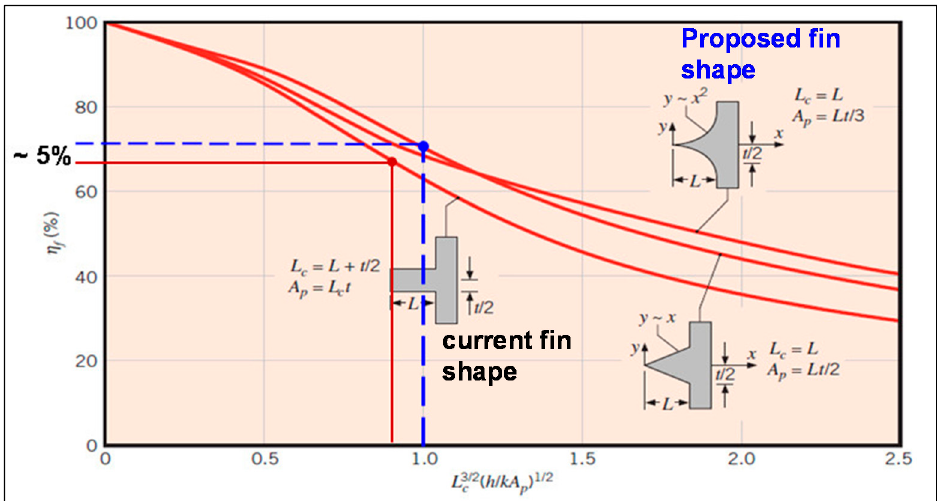
Figure 21. Efficiency of straight fins (from [29]).